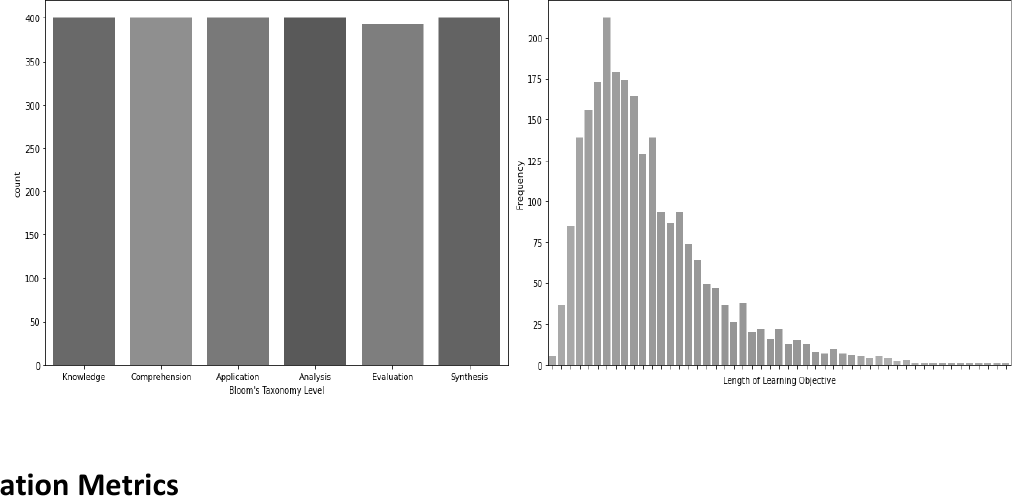
Distribution of Data by Level and Item